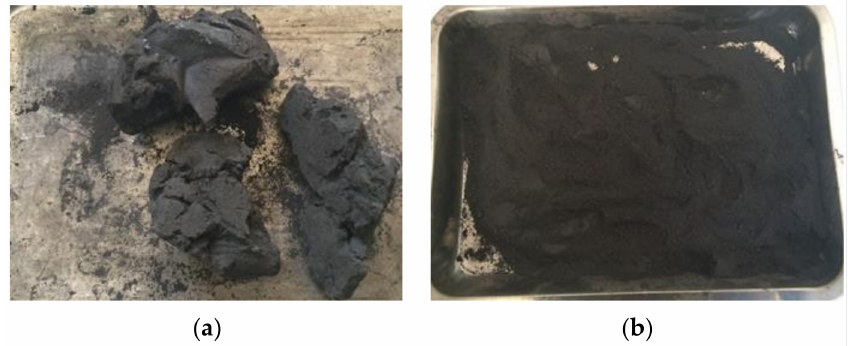
Figure 2. ( a ) Hardened sludge; ( b ) coal powders after